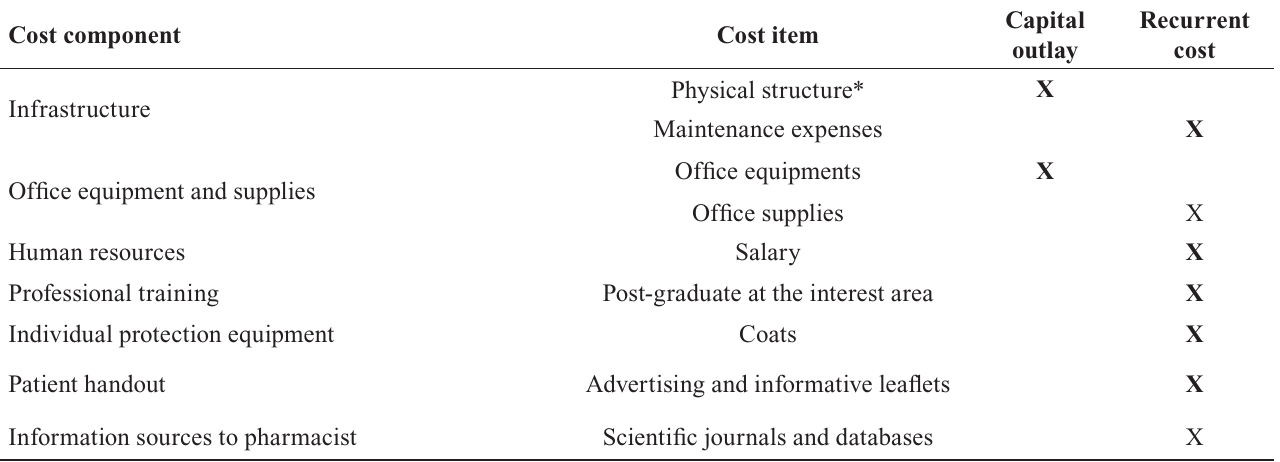
TABLE I – Cost components and cost items of medicine dispensing service in a community pharmacy, Goiânia, Goiás, Brazil